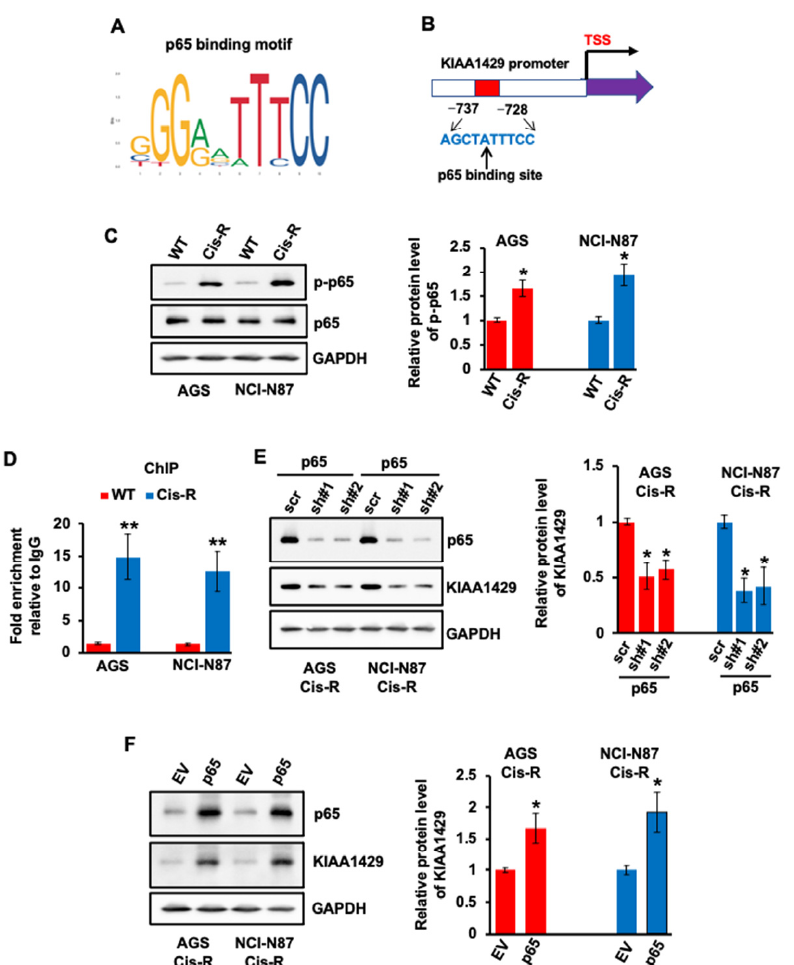
Figure 3. Effect of p65 on regulating KIAA1429 expression. ( A ) The canonical binding motif of p65. ( B ) Schematic diagram of KIAA1429 promoter region con-taining one putative p65 binding sites. ( C ) The phosphorylation of p65 and total p65 levels in AGS Cis-R or NCI-N87 Cis-R and their pa-